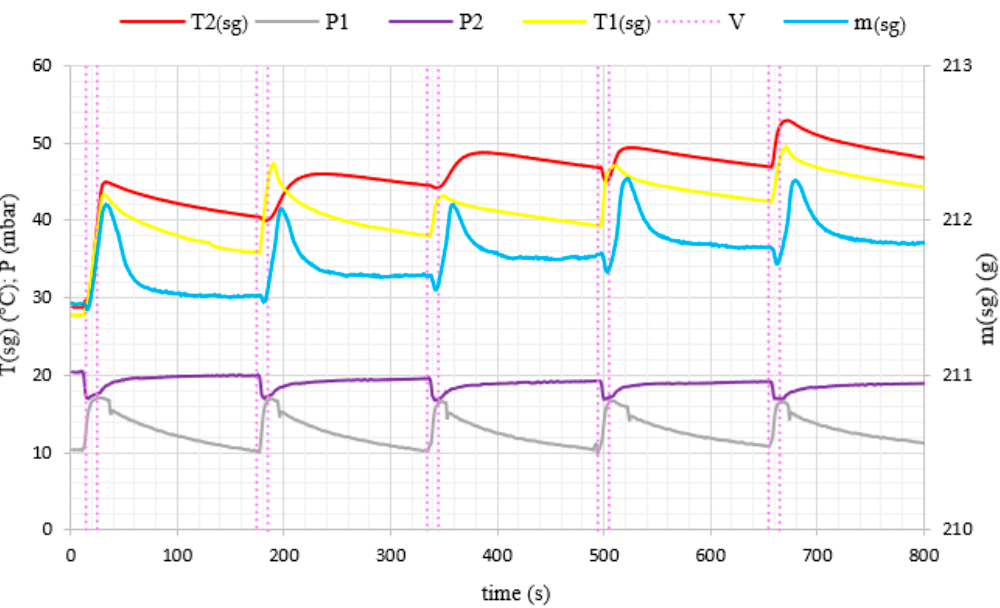
Figure 9. The changes of pressure, temperature and mass of evaporated water with time profiles in the adsorption chamber corresponding to fluidized bed conditions (Spherical SG from Fuji Silysia Chemical Ltd.).